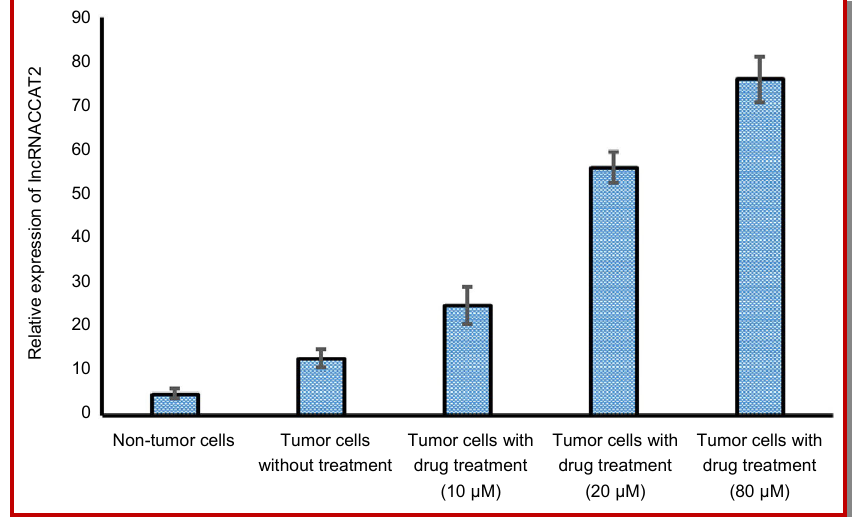
Figure 6: Graphical representation of LncRNA CCAT2 expression in iridomyrmecin treated and untreated cervical cancer and nearby non-cancer tissues detected by